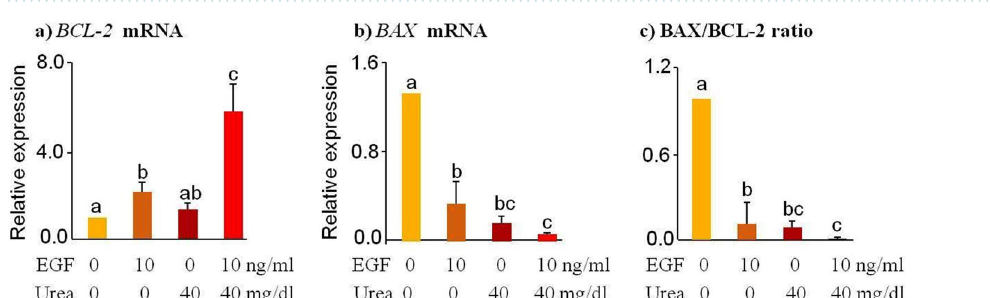
Figure 5. The gene expression in blastocysts derived from sperm pre-incubated with EGF or urea. Bovine sperm cells were pre-incubated with urea (40 mg/dl) for 30 min in the presence or absence of EGF (10 ng/ ml). ( a – c ) Relative mRNA expression of BCL-2 (anti-apoptotic gene) and BAX (pro-apoptotic gene) in day-9 blastocysts. Data was obtained with a total of six replicates (n = 6, 28–36 embryos per replication) and analyzed using the Tukey test. Numerical values are presented as mean ± S.E.M. Different letters (a, b, c) indicate significant differences between treatments at P <